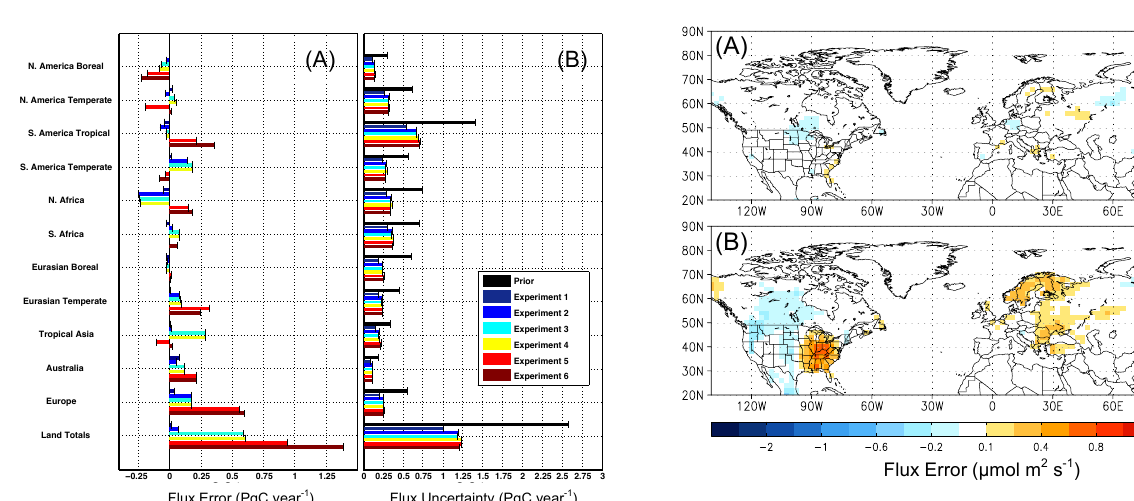
Fig. 5. Bar plots of total annual terrestrial flux error (A) and un- certainty (B) for Experiments 1–6, aggregated up to regional and global scale.